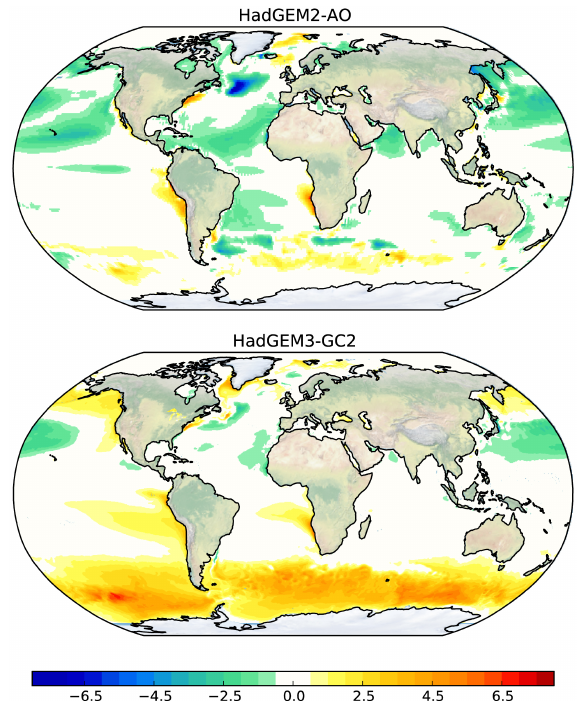
Figure 1. Mean SST bias (K) against EN3 for the CLIM experiment for HadGEM2-AO and